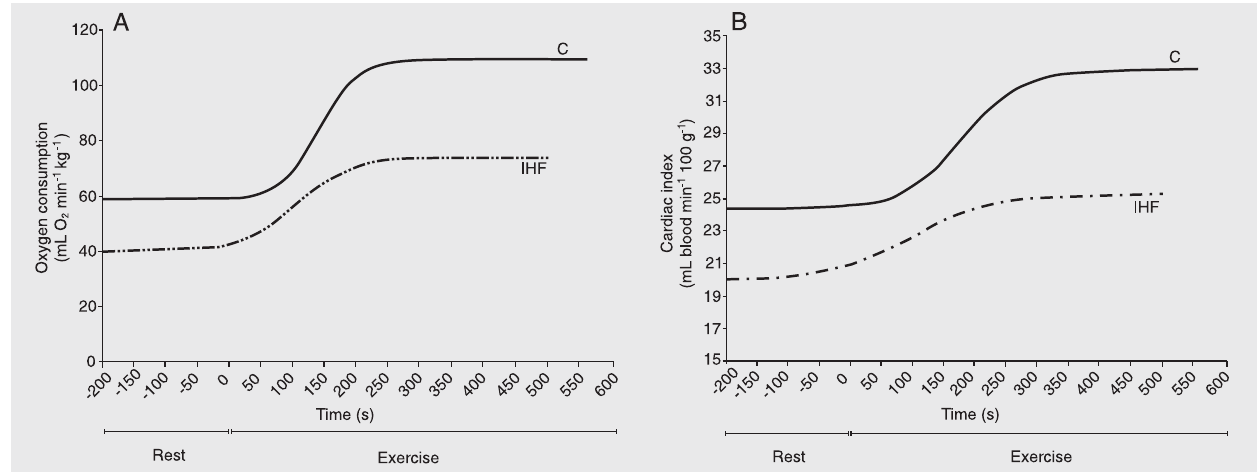
Figure 2. Time course of oxygen consumption (panel A) and cardiac output (panel B) during progressive exercise of normal control rats (C) and ischemic heart failure rats (IHF). Note that both the oxygen consumption (panel A) and cardiac output (panel B) temporal responses were reduced in ischemic heart failure rats compared to normal